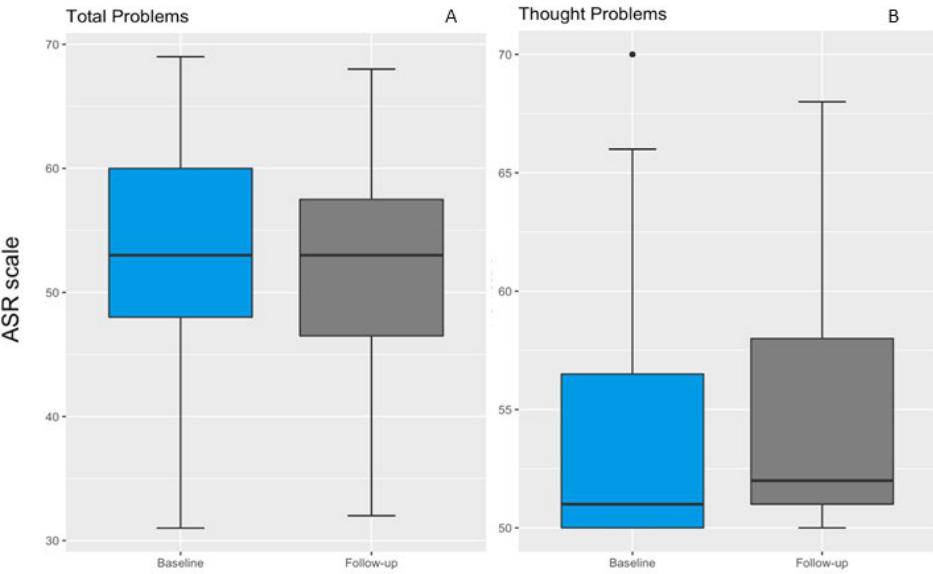
Figure 2. Differences in ASR score between baseline and follow-up. The boxplot shows YSR/ASR